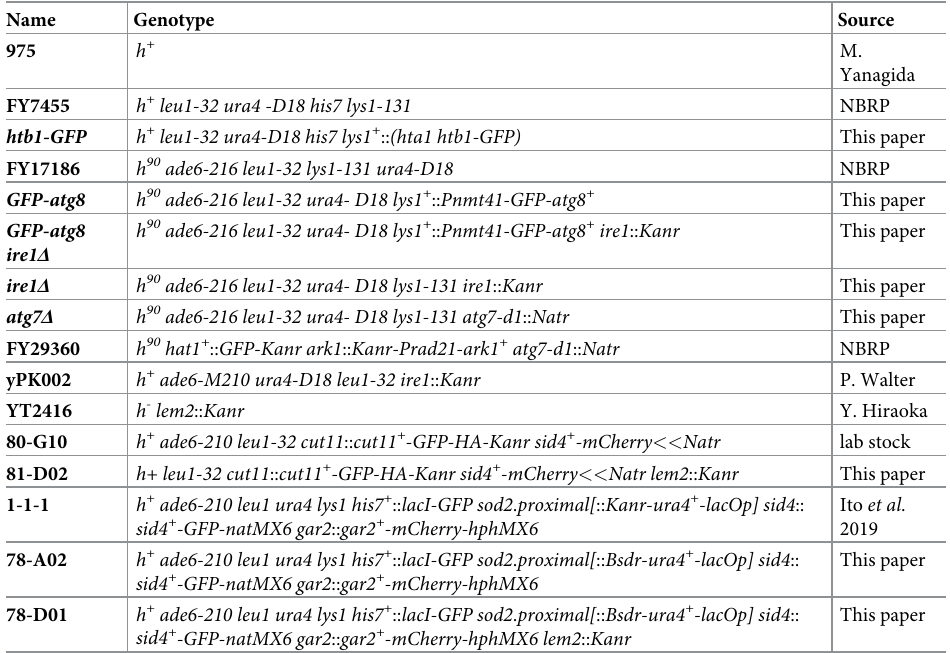
Table 1. The strains used in this